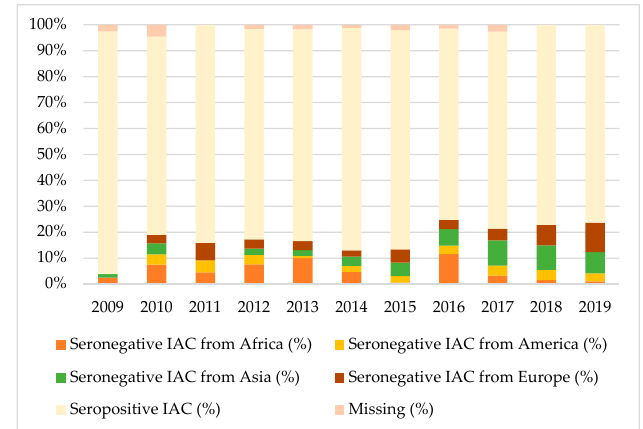
Figure 2. Percentages of seropositive and seronegative children in the study for tetanus, by year of the first visit in Italy and country of origin . Vaccines 2020 , 8 , x